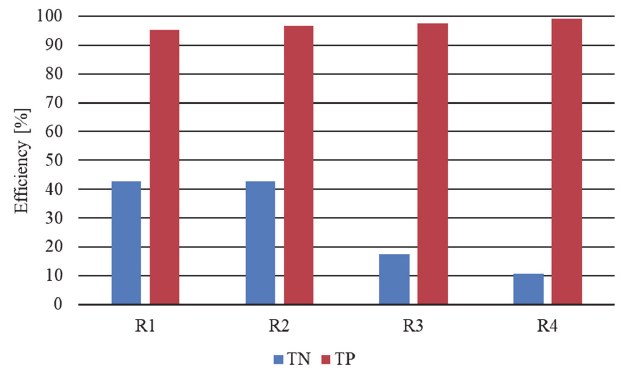
Figure 3. Efficiency of total nitrogen and total phosphorus removal from hydroponic effluent in a BER.